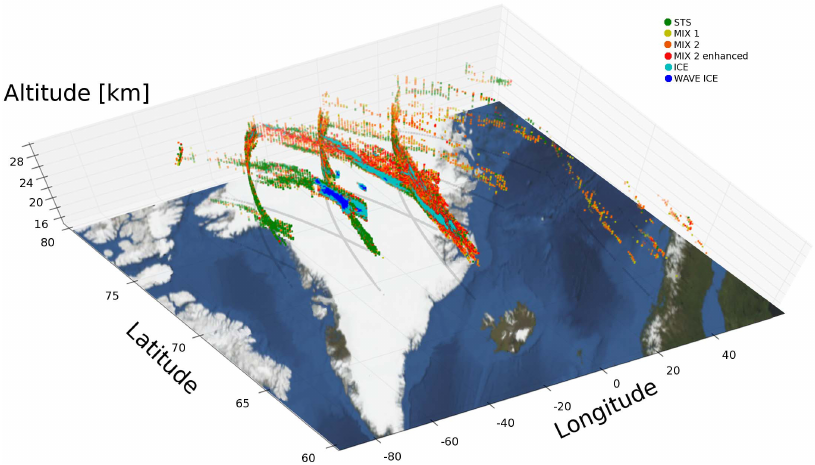
Figure 2. CALIOP PSC observations along orbits over Greenland on 2 January 2010 color coded according to the CALIOP classification. Green: STS; Yellow: MIX 1; Orange: MIX 2; Red: MIX 2 enhanced; Cyan: Synoptic Ice; Blue: Wave